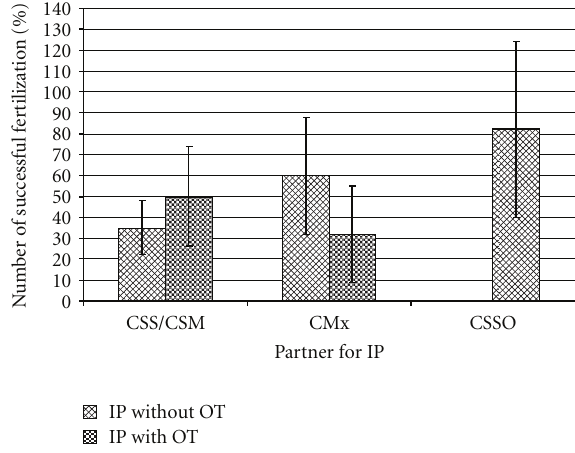
Figure 2: The comparison of successful fertilization (% of growing pollen tubes) after in vitro pollination between 2x cucumber (IP without OT) and 2x/4x cucumber plants (IP with OT) with other Cucumis species. Abbreviations: CSS, CSM, and CMx: set of tested Cucumis spp., CSSO: mixoploid C. sativus obtained after OT; IP: in vitro pollination; OT: oryzalin treatment; Y-error bars represent standard